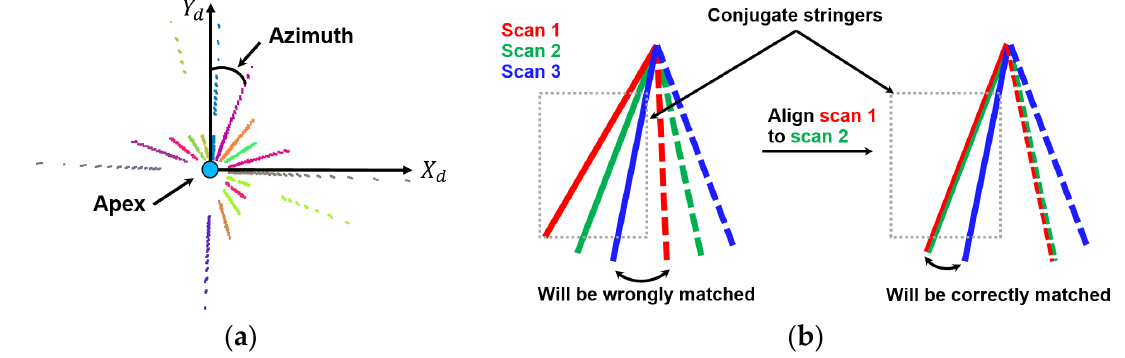
Figure 19. Illustration for the stringer matching: ( a ) definition of the stringer azimuth and ( b ) the successive matching procedure for mitigating the error propagation.